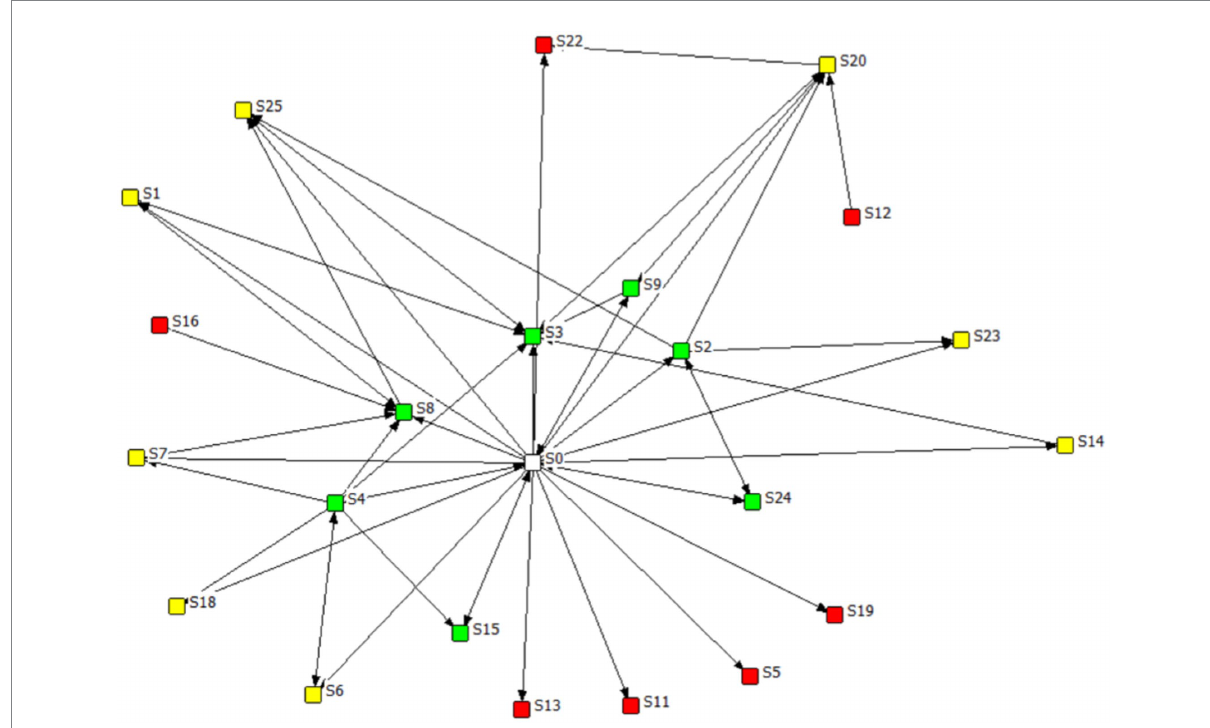
FIGURE 2 Students’ participation network. The green squares are participants identified as leaders, the yellow as regular, and the red as